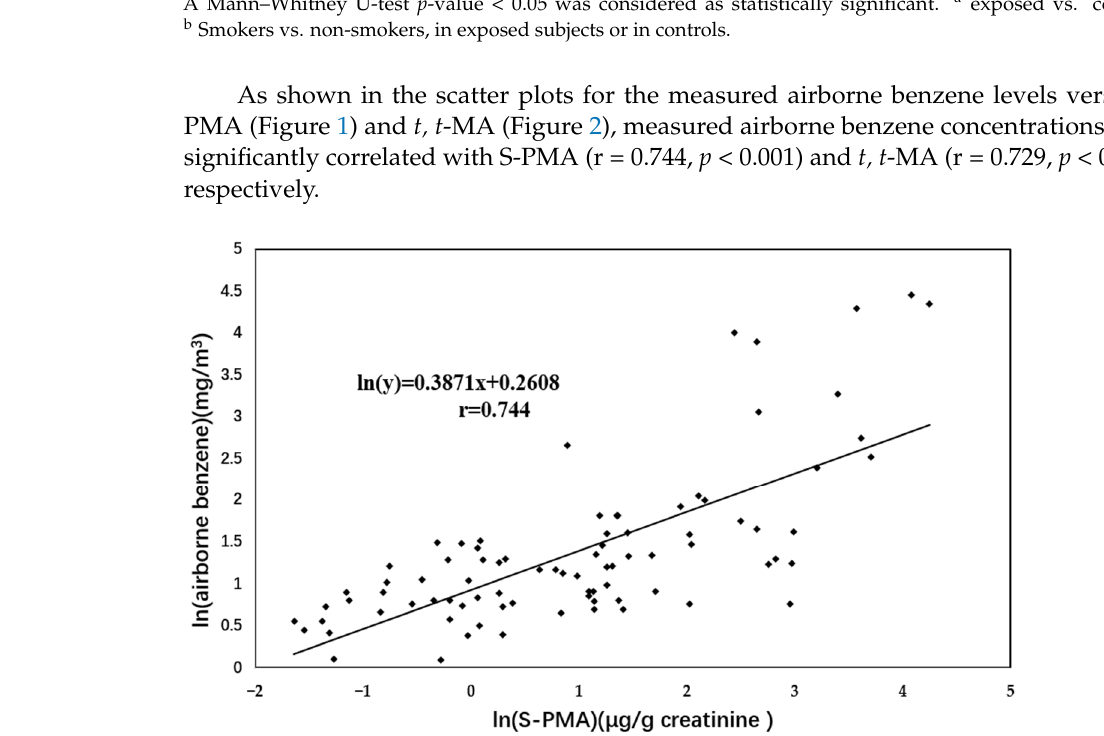
Table 2. Summary statistics for urinary metabolite excretion in control and exposed subjects.